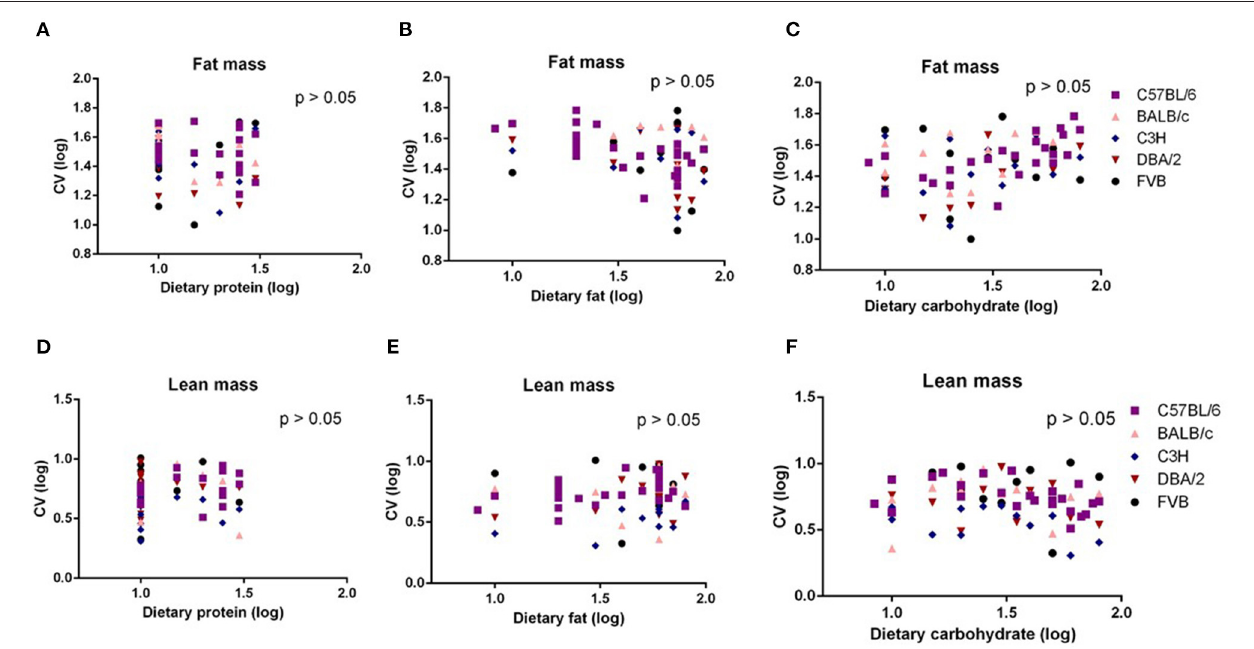
FIGURE 3 | The diagram showing the relationship between dietary macronutrient content and the coefficient of variation (CV) of fat mass and lean mass. The correlations between logged dietary fat, protein, and carbohydrate contents and (A–C) logged CV of fat mass and (D–F) lean mass of the last week (10th week) at different diet treatment periods, respectively ( n = 7–21).